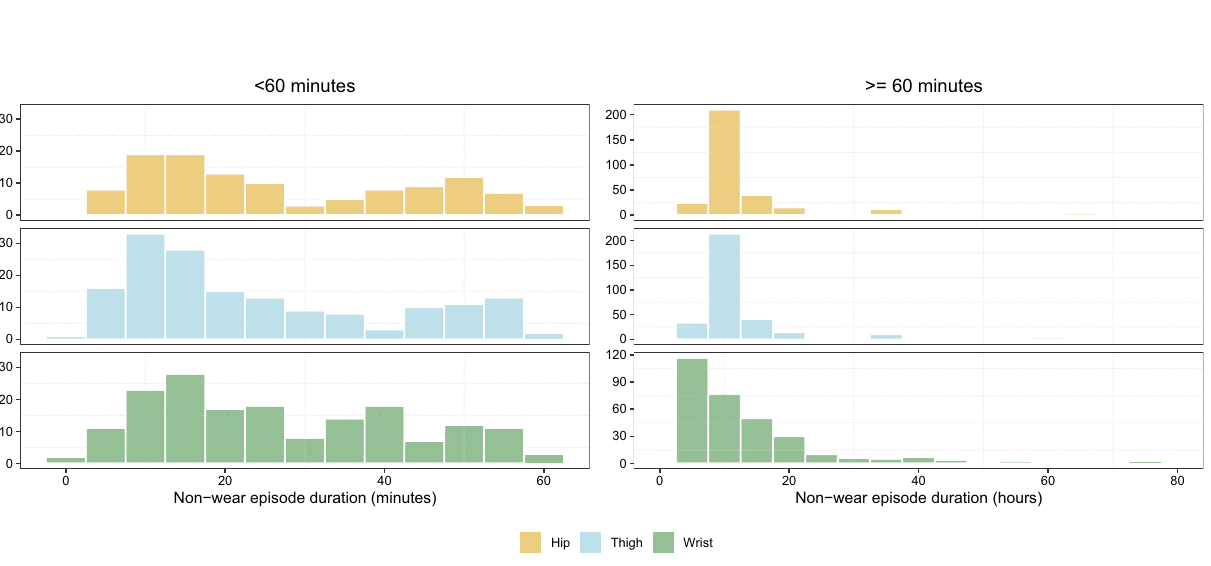
Figure 3. Distribution of the length of the non-wear episodes across hip, thigh, and wrist data. Distributions are shown for episodes shorter than 60 min and longer than 60